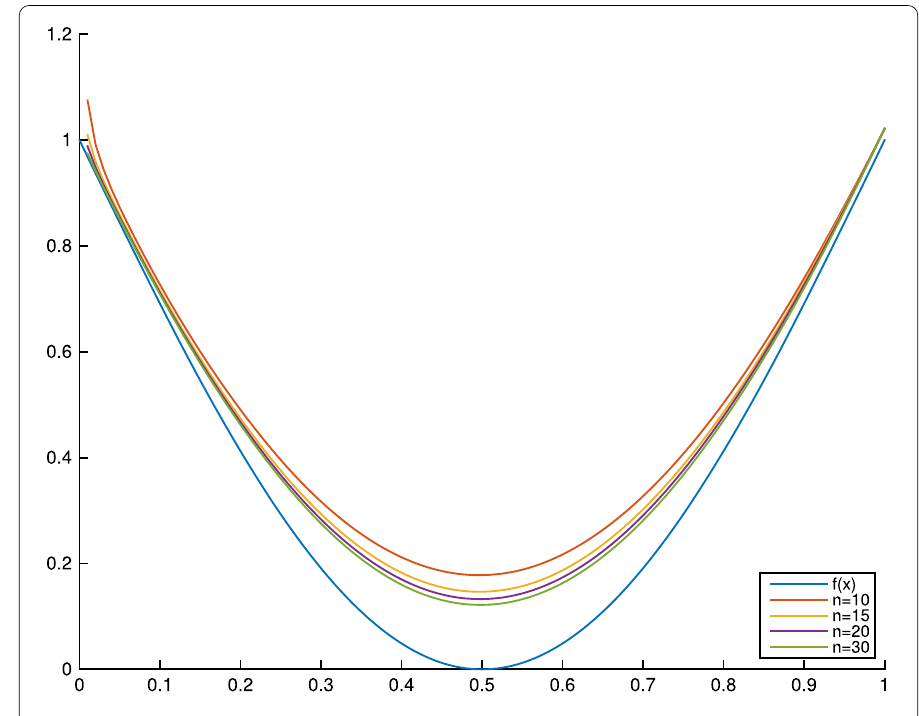
Figure 3 Monotonicity of T n , q , α ( f ; x ) in the parameter n